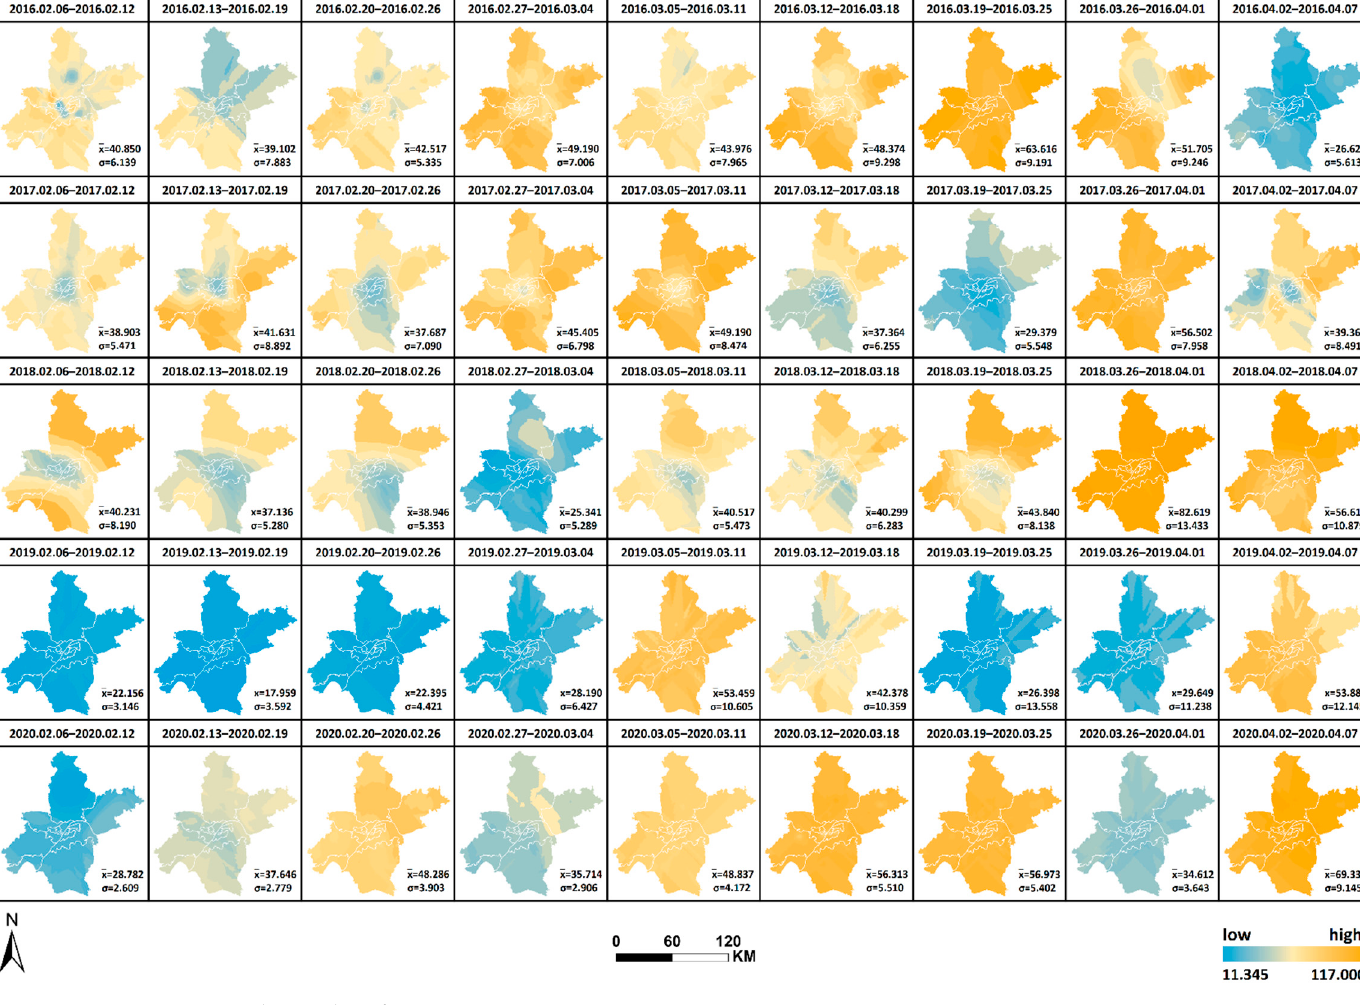
Figure 12. O 3 interpolation chart from 2016 to 2020.